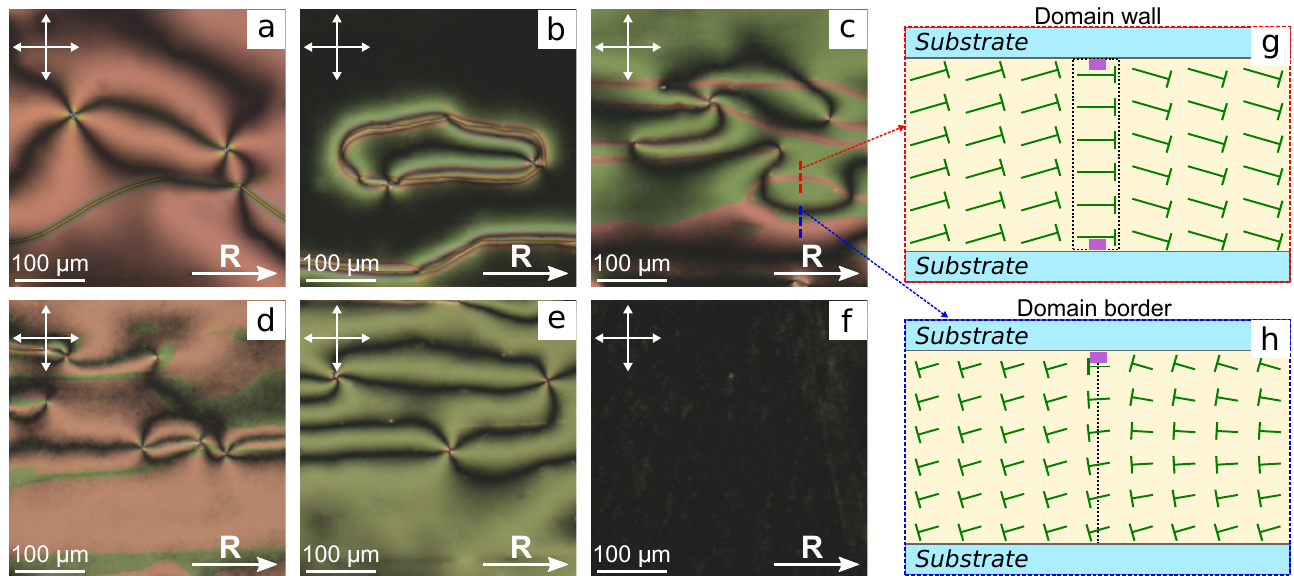
Figure 3. POM photos of LC cells with substrates covered with PiBMA:PMMA mixture with weight ratio polymers equal to: ( a ) 100:0, ( b ) 80:20, ( c ) 60:40, ( d ) 40:60, ( e ) 20:80, and ( f ) 0:100. Scheme of the director orientation in LC cell cross-section along ( g ) red and ( h ) blue dash lines. Nails show the director orientation oblique to the figure plane. The nail length is proportional to the director projection onto the figure plane. Acute ends of nails correspond to the director pointing towards the observer. Hereinafter, the solid arrow indicates the rubbing direction R , the polarizer directions are indicated by double